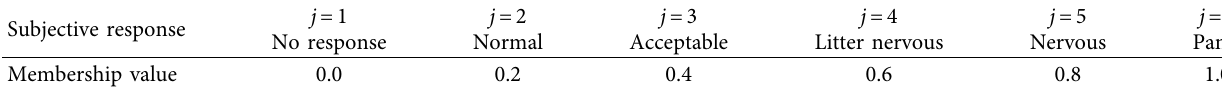
Table 4: Seismesthesia membership